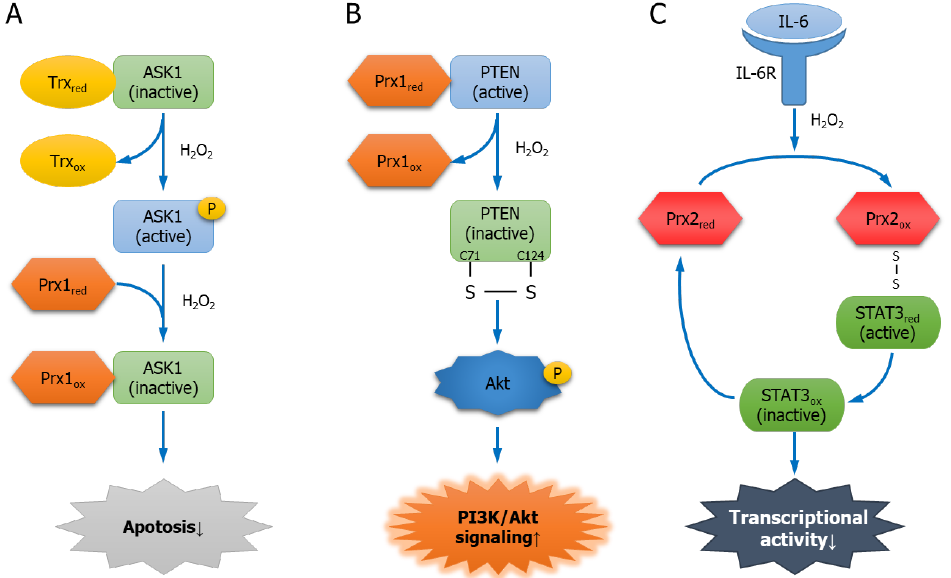
Figure 2. The regulatory mechanism of Prx1 or Prx2 interacting partners. ( A ) Interaction between Prx1 and apoptosis signal regulating kinase 1 (ASK1). ASK1, which induces apoptosis, is inactivated by interaction with thioredoxin (Trx). H 2 O 2 activates ASK1 by interfering with the interaction between the two proteins. However, high concentrations of H 2 O 2 increase the interaction between Prx1 and ASK1. As a result, Prx1 decreases ASK1 activity and inhibits apoptosis; ( B ) interaction between Prx1 and phosphatase and tensin homolog (PTEN). Prx1 interacts with PTEN to protect its lipid phosphatase activity. However, H 2 O 2 oxidizes Prx1 and dissociates it from PTEN. PTEN is inactivated by forming a disulfide bond. Finally, Akt phosphorylation is induced and PI3K / Akt signaling is activated; ( C ) interaction between Prx2 and signal transducer and activator of transcription 3 (STAT3). Interleukin-6 (IL-6) or H 2 O 2 oxidizes Prx2. Oxidized Prx2 binds to STAT3, causing redox relay and oxidizing STAT3 by forming disulfide exchange intermediates. The transcriptional activity of oxidized STAT3 is decreased.